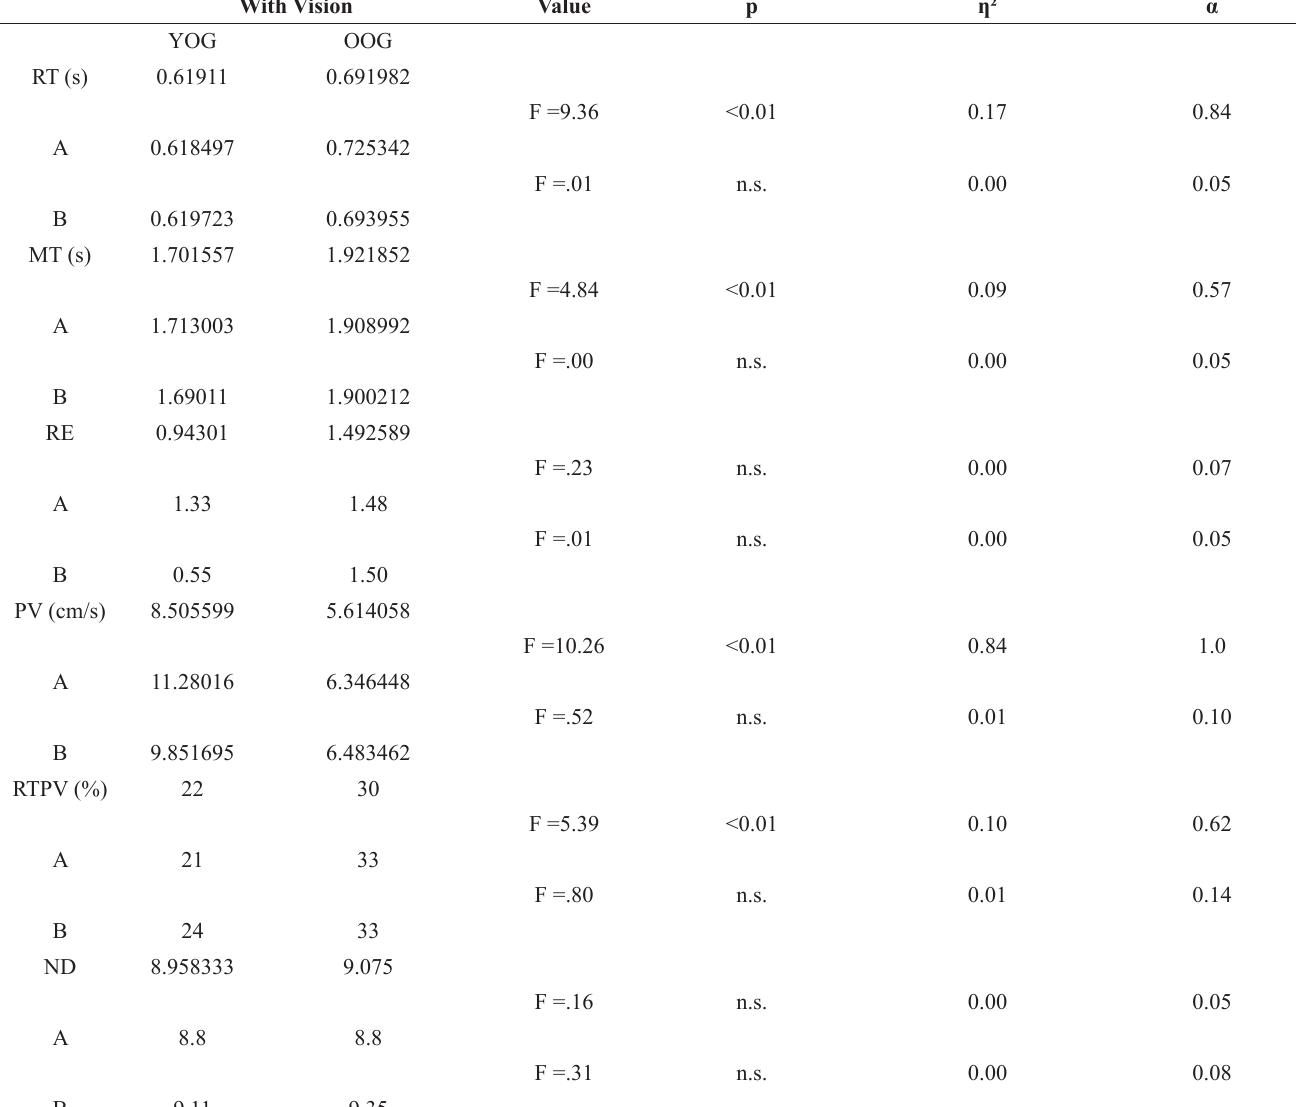
Table 3. Results of Experiment